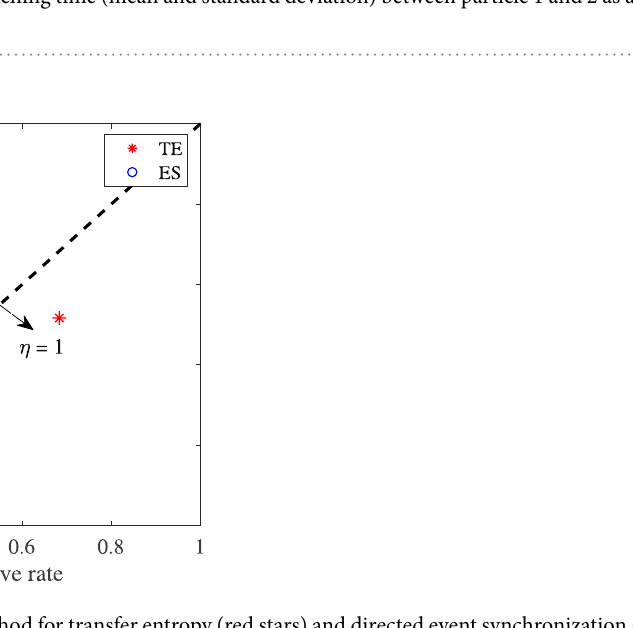
Figure 5. Performance of the method for transfer entropy (red stars) and directed event synchronization (blue circles). This ROC is parametrized here by noise intensities from 0 to 1 in 0.1 increments, that is η = 0.1, 0.2, … , 1 (black arrow). The threshold utilized is identical for all point ( A 0 0040 point (0, 0) correspond to noise level η = 0 and other model parameters retained in the simulations are N = 2, K = 2, v = 0.05.